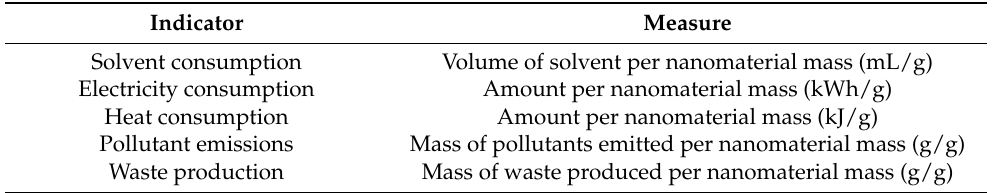
Table 2. Suggested KPIs inspired from green chemistry principles [35].